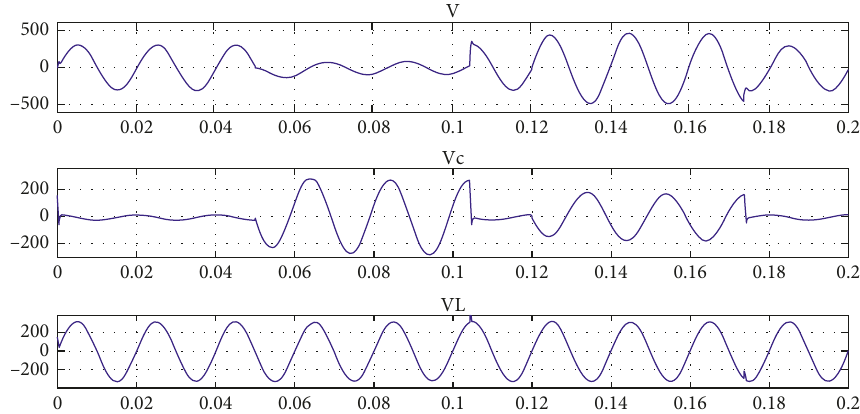
Figure 17: Result of the DVR system simulation by virtual comparison.